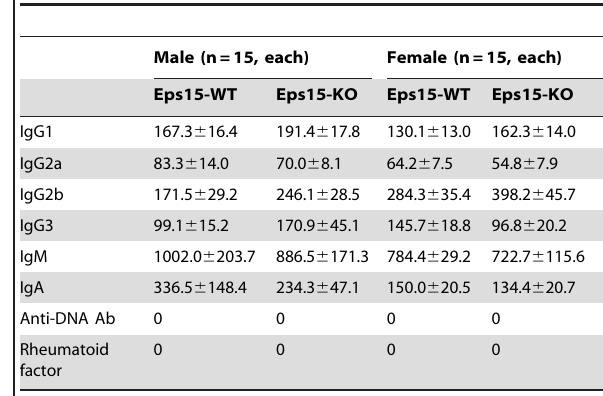
Table 7. Normal Ig and absence of auto-antibodies in young Eps15-KO mice.